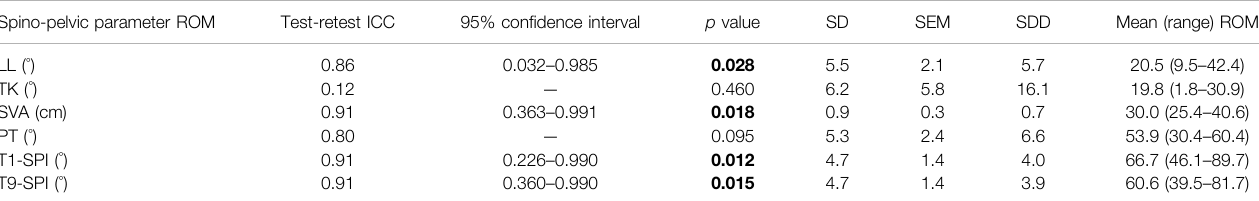
TABLE 1 | Results of the test-retest reliability analysis. ROM, range of motion; ICC, intraclass correlation coef fi cient; SD, standard deviation of the absolute differences betweenbothsessions;SEM,standarderrorofmeasurement; SDD,smallestdetectabledifference.Signi fi cancelevel: p < 0.05(bold). Thecon fi denceintervalsforICC ’ s with a non-signi fi cant p value are not